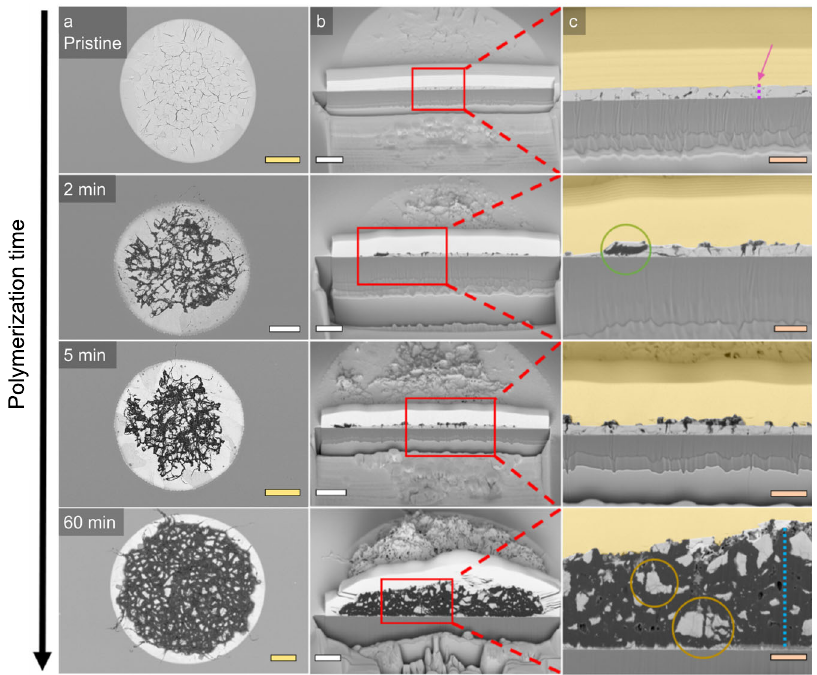
Fig. 4 | Cross-sectional scanning electron microscopy (SEM) to study the fragmentation behaviour of the ethylene polymerized LaOCl spherical caps. a Top-down overview ofthe full spherical caps at respectively 0 (pristine), 2, 5 and 60min of ethylene polymerization. b A cross-section of the spherical caps that shows the internal structure of the polyethylene-LaOCl spherical cap composites. c A zoom-in of these cross-sections to provide enhanced view of the internal structure. The pink and blue dashed lines in respectively the pristine and 60min ethylenepolymerized samplesshow a thickness of 600nm forthe LaOClspherical